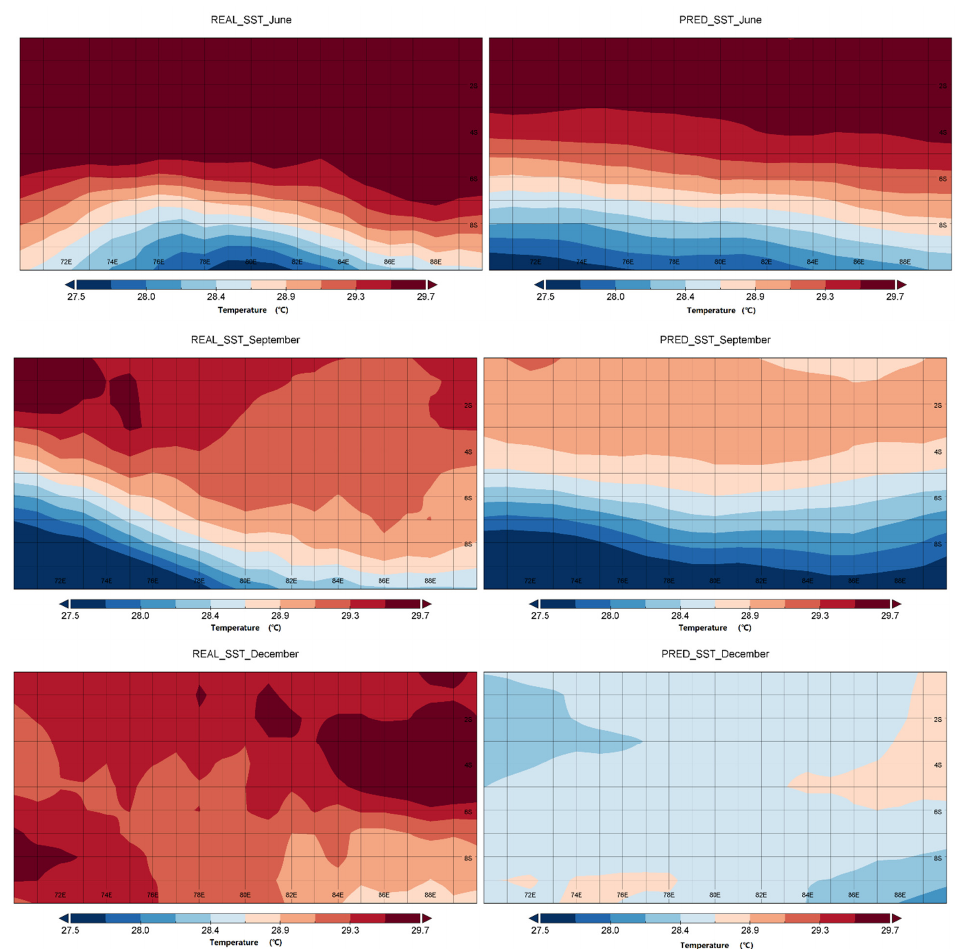
Figure 8. Comparison of regional real and predicted sea surface temperature (70° E–90° E, equator to 10° S) for June, September and December 2015.